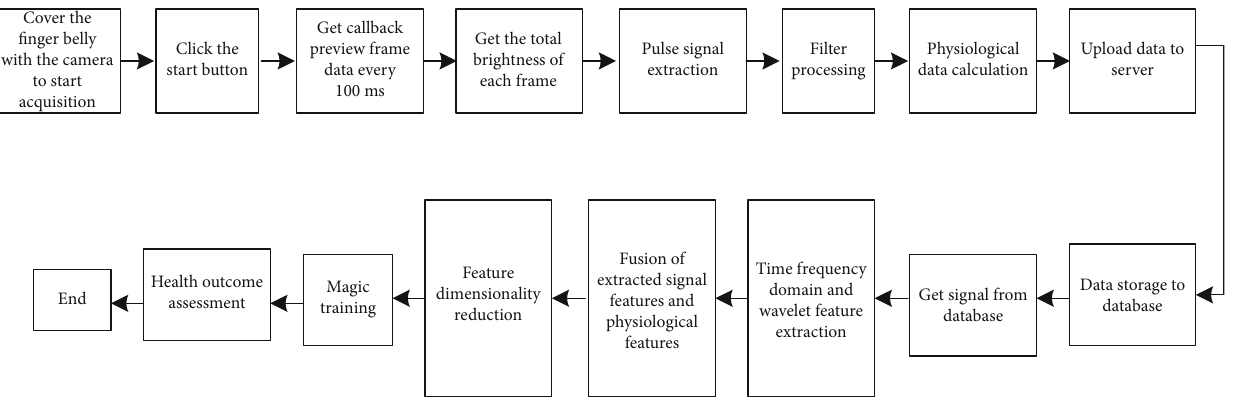
Figure 6: Evaluation process of human health status after sports training.